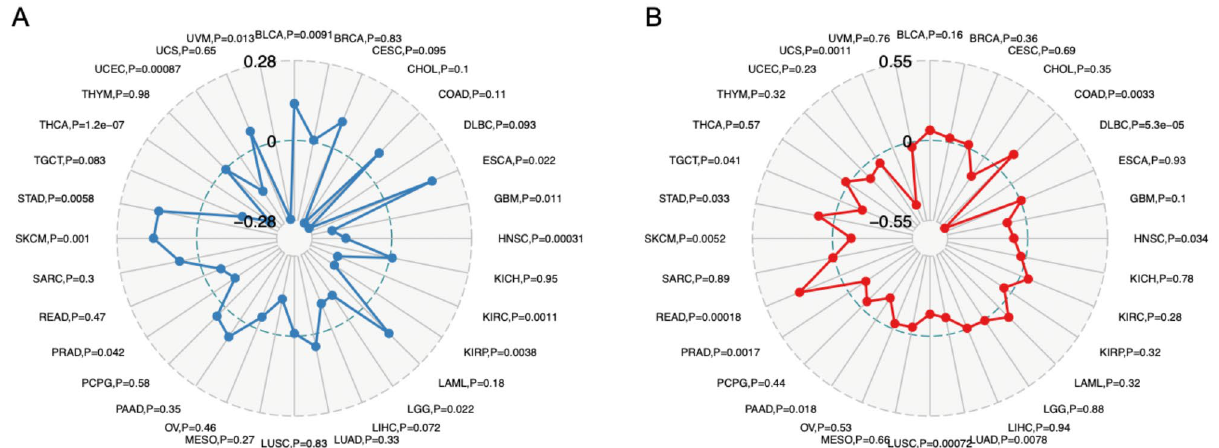
Figure 7. Radar map plotting showed the relationship between CD47 expression and TMB ( A ), CD47 expression and MSI ( B ) in 33 cancer types. ( A ) Increased expression of CD47 was positively associated with TMB in BLCA, ESCA, SKCM, STAD, while negatively correlated with GBM, HNSC, KIRC, KIRP, LGG, PRAD, THCA, UCEC and UVM. ( B ) Increased expression of CD47 was positively related to COAD, READ, STAD,and negatively associated with DLBC, HNSC, LUAD, LUSC, PAAD, PARD, SKCM, TGCT, and UCS.